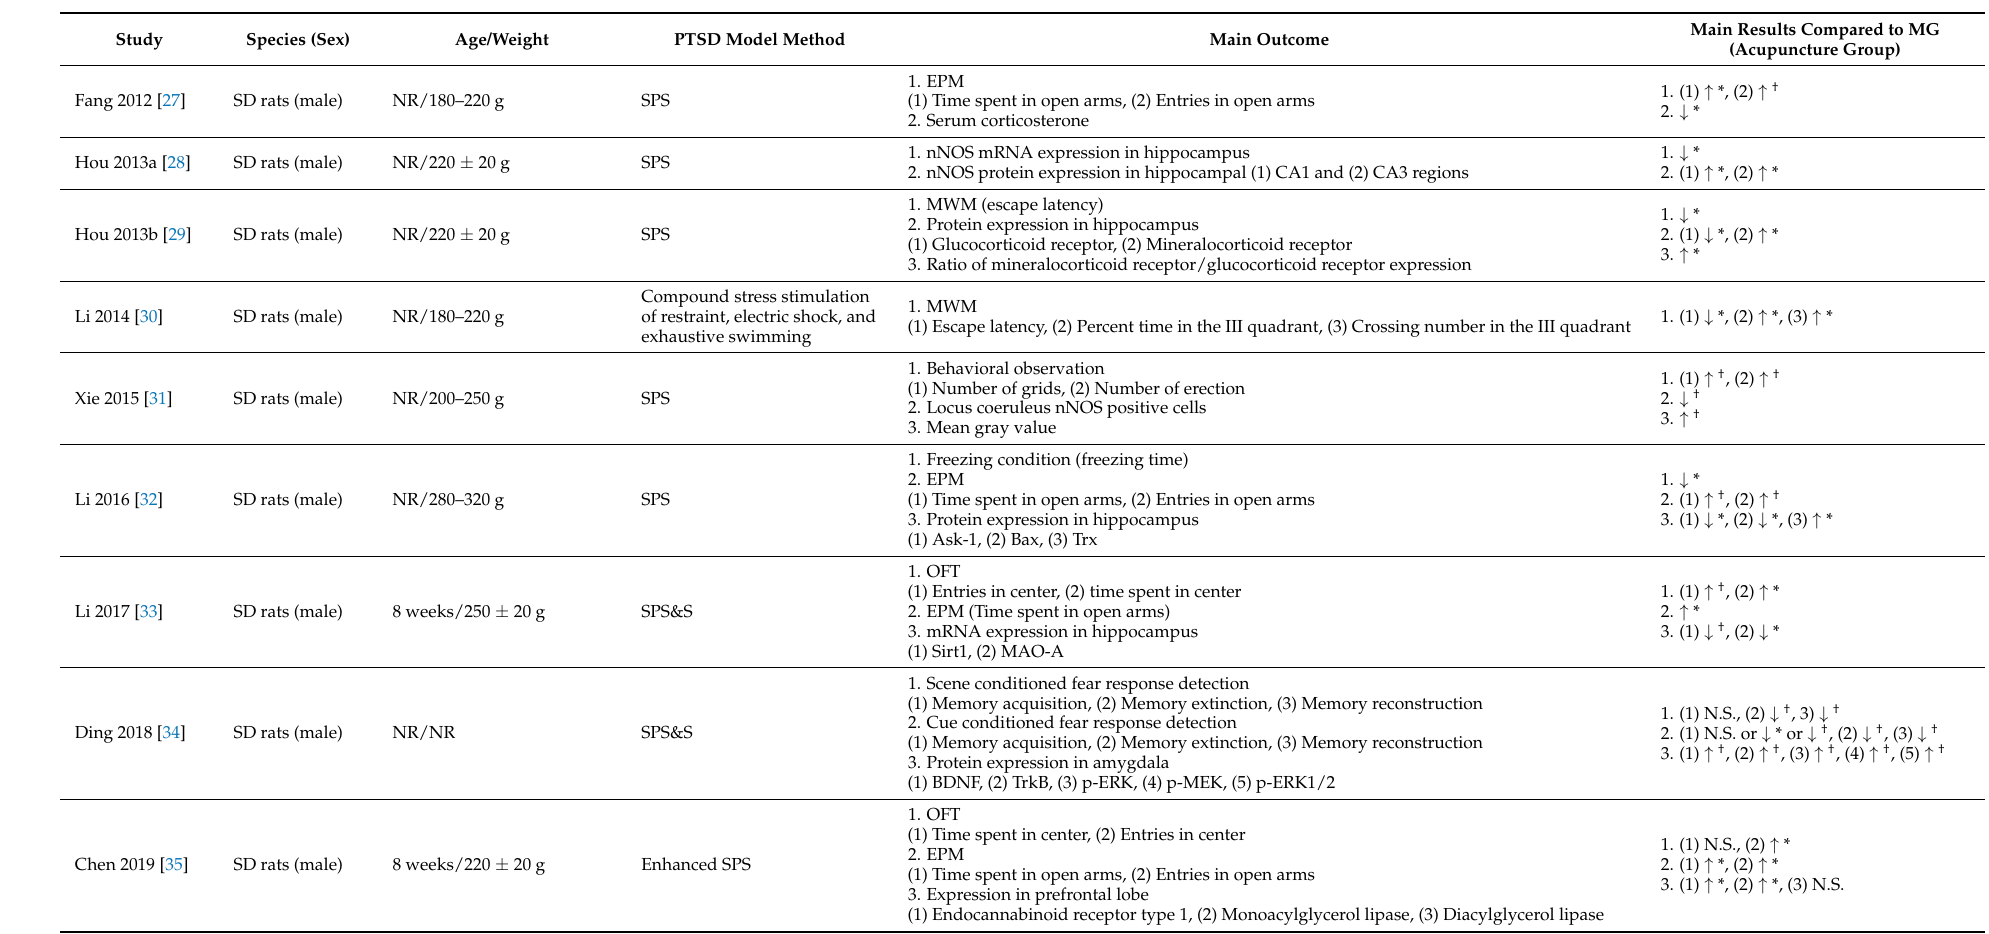
Table 1. Characteristics of included